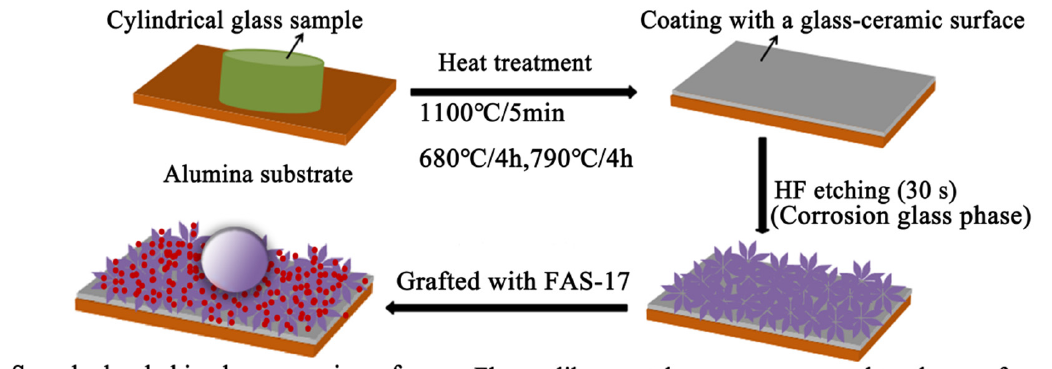
Figure 2. Schematic illustration of the preparation of a durable superhydrophobic glass-ceramic surface.